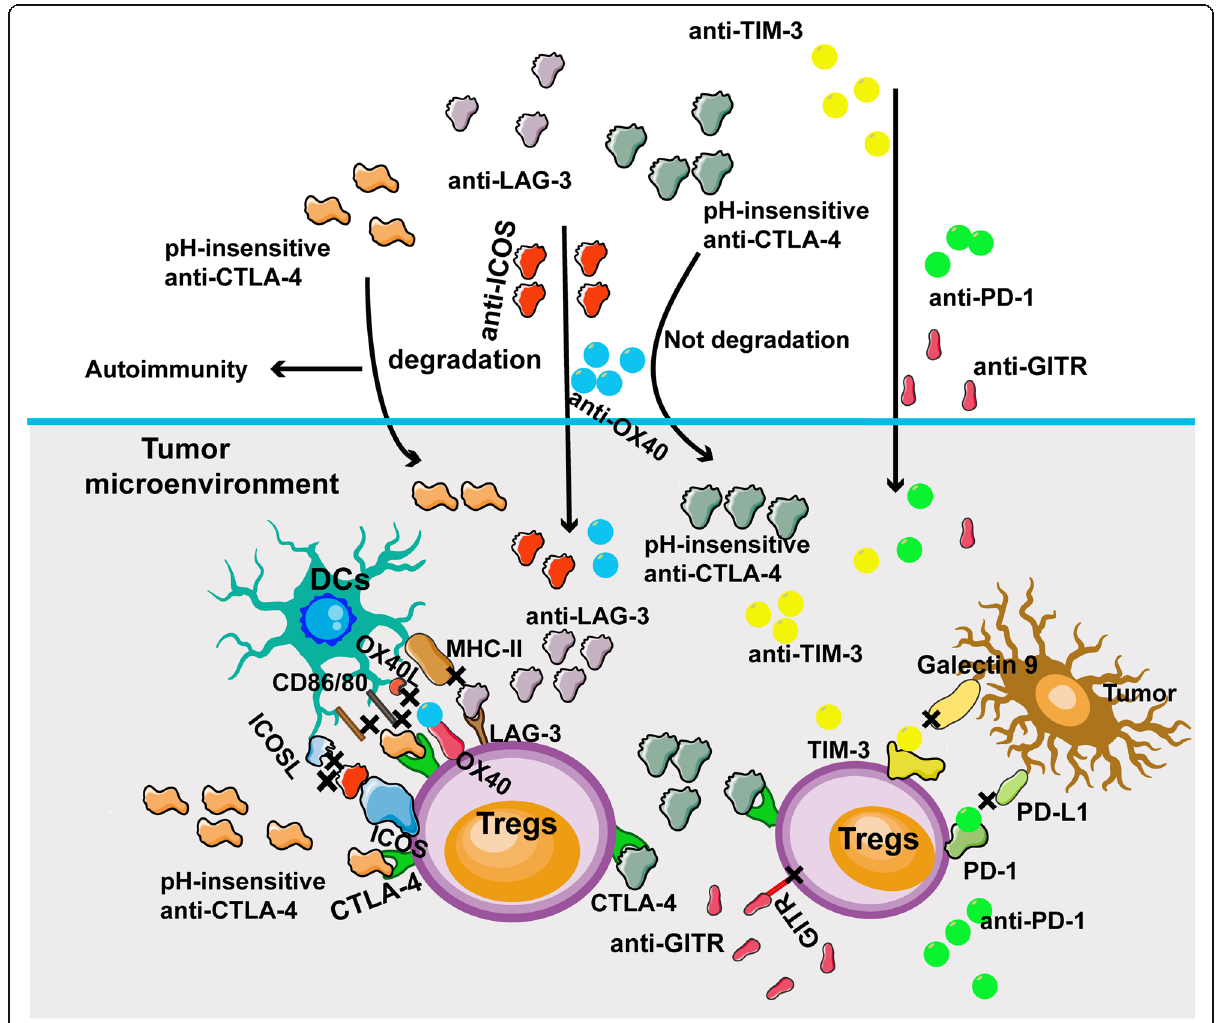
Fig. 4 Immune checkpoint therapies targeting Tregs in melanoma. In the TME, anti-PD-1 mAbs block the PD-1 function on the Tregs. Anti-CTLA-4 mAbs induce Treg cell depletion by activating the Fc receptors. However, current CTLA-4 mAbs often result in severe immune-therapy related adverse events. A new version of anti-CTLA-4 (pH-sensitive CTLA-4) mAbs do not degrade in the lysosomal and recirculate to the cell surface of Tregs, reducing the adverse immune events. Anti-TIM-3 mAbs exhibit dual functions in depleting Tregs and stimulating CD8 + T cells. Anti-LAG-3 mAbs prevent Treg recruitment and promote DCs function in melanoma therapy. Other antibodies targeting OX-40 and ICOS inhibit proliferation of Tregs in the TME. The anti-GITR mAbs reduce circulating and intratumor Tregs in advanced melanoma